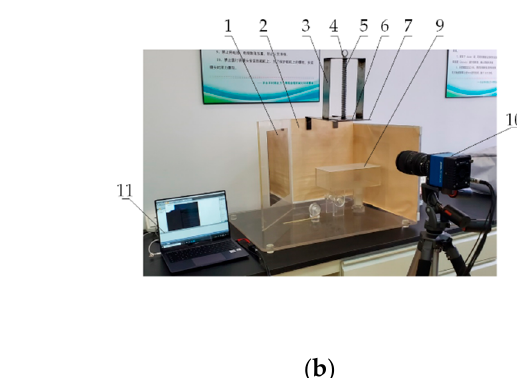
Figure 2. Contact materials: ( a ) rubber plate; ( b ) Q235 steel plate; ( c ) plexiglass plate; and ( d ) seed plate.